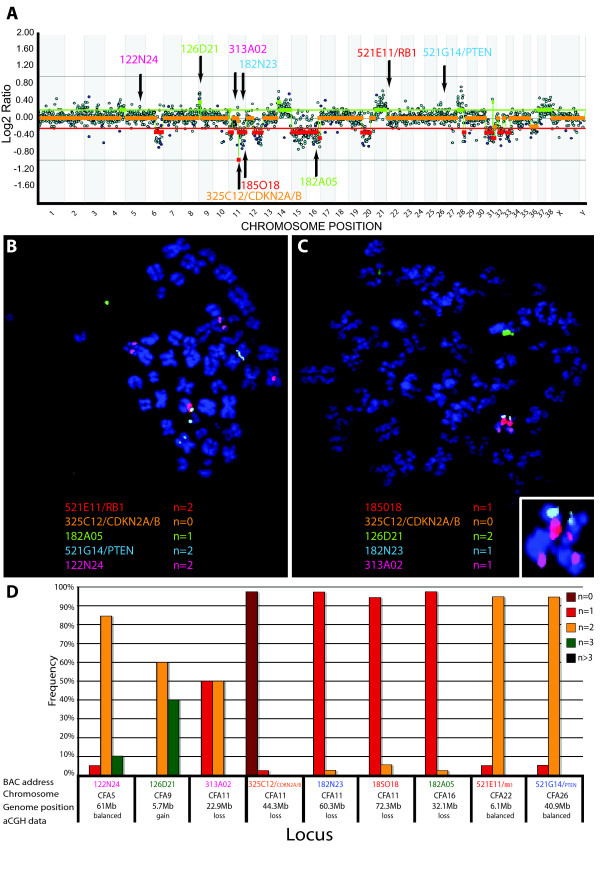
Molecular cytogenetic evaluation of a canine histiocytic malignancy using aCGH and FISH. A. Example of whole genome aCGH profile of a HS in a five year old female FCR. Log2 ratios representing thresholds of genomic gain and loss are indicated by horizontal bars above (green line) and below (red line) the midline (orange line), which represents normal copy number. The chromosome copy number status line for the tumor appears as an orange overlay of the center-line when there is a normal copy number, and as either green (gain) or red (loss) in the regions where genomic imbalances were apparent, as determined by the aCGH Smooth algorithm [29]. The aCGH profile is annotated with the clone address of nine BAC clones from the 1 Mb array that were used in subsequent FISH analysis of this case. Three of these nine clones have been shown previously to contain the full coding sequence of a key cancer-associated gene (CDKN2A, RB1, PTEN) [26]. The color of the text denotes the fluorochrome with which the BAC clone was labeled. B, C Targeted FISH analysis of tumor metaphase chromosome spreads from the same case using nine differentially labeled BAC clones (highlighted in A) combined in two separate groups. The modal copy number for each clone is indicated. D. Summary of copy number data of all nine loci evaluated by FISH analysis of at least 30 tumor interphase nuclei or metaphase spreads. The aCGH copy number status of these regions (gain, loss, balance) are indicated, demonstrating concordance between FISH data and aCGH data.